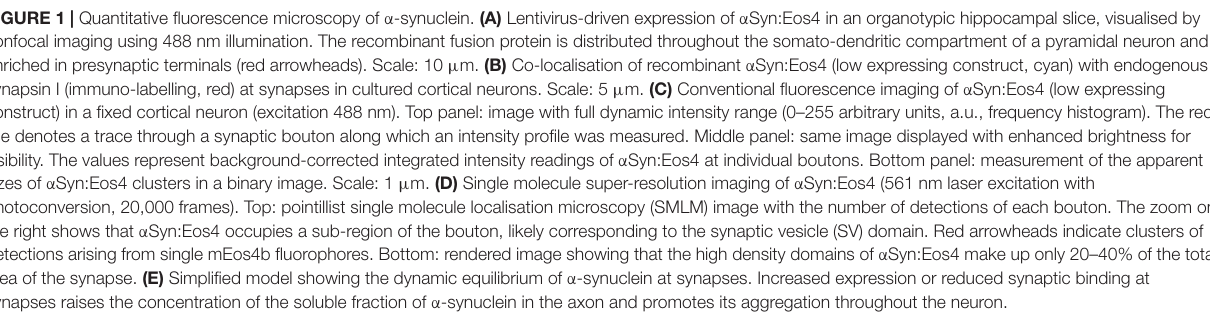
FIGURE 1 | Quantitative fluorescence microscopy of α -synuclein. (A) Lentivirus-driven expression of α Syn:Eos4 in an organotypic hippocampal slice, visualised by confocal imaging using 488 nm illumination. The recombinant fusion protein is distributed throughout the somato-dendritic compartment of a pyramidal neuron and enriched in presynaptic terminals (red arrowheads). Scale: 10 µ m. (B) Co-localisation of recombinant α Syn:Eos4 (low expressing construct, cyan) with endogenous synapsin I (immuno-labelling, red) at synapses in cultured cortical neurons. Scale: 5 µ m. (C) Conventional fluorescence imaging of α Syn:Eos4 (low expressing construct) in a fixed cortical neuron (excitation 488 nm). Top panel: image with full dynamic intensity range (0–255 arbitrary units, a.u., frequency histogram). The red line denotes a trace through a synaptic bouton along which an intensity profile was measured. Middle panel: same image displayed with enhanced brightness for visibility. The values represent background-corrected integrated intensity readings of α Syn:Eos4 at individual boutons. Bottom panel: measurement of the apparent sizes of α Syn:Eos4 clusters in a binary image. Scale: 1 µ m. (D) Single molecule super-resolution imaging of α Syn:Eos4 (561 nm laser excitation with photoconversion, 20,000 frames). Top: pointillist single molecule localisation microscopy (SMLM) image with the number of detections of each bouton. The zoom on the right shows that α Syn:Eos4 occupies a sub-region of the bouton, likely corresponding to the synaptic vesicle (SV) domain. Red arrowheads indicate clusters of detections arising from single mEos4b fluorophores. Bottom: rendered image showing that the high density domains of α Syn:Eos4 make up only 20–40% of the total area of the synapse. (E) Simplified model showing the dynamic equilibrium of α -synuclein at synapses. Increased expression or reduced synaptic binding at synapses raises the concentration of the soluble fraction of α -synuclein in the axon and promotes its aggregation throughout the